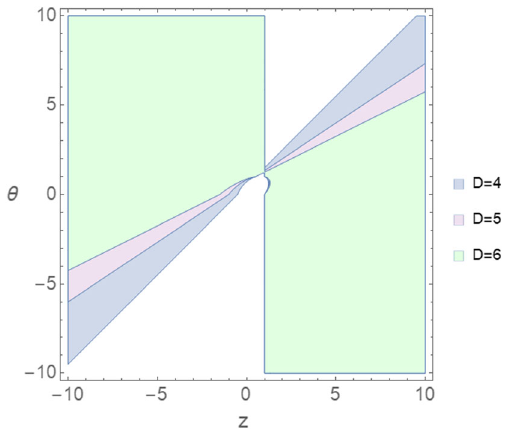
Fig. 6 The NEC evaluated asymptotically as ρ → 0. The colored regions are the allowed parameter combinations exemplified for D = 4 , 5 , 6 (blue, light purple, light green respectively). Other dimensions feature a similar behaviour except that the allowed area decreases for a greater D . Distinct ( z ,θ) combinations inside the blank area will lead to violation of the energy condition. The asymptotic NEC coincide with the bare hyperscaling violating Schrödinger spacetime derived in [38]